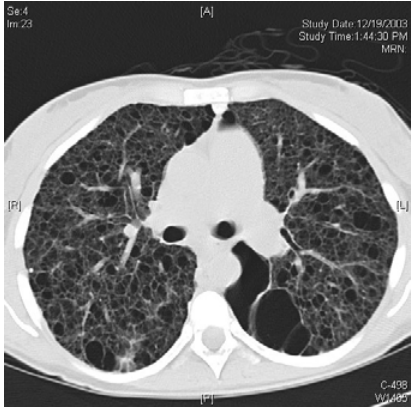
FIGURE 1. CT chest demonstrates innumberable thin-walled cysts diffusely distributed throughout both lungs.